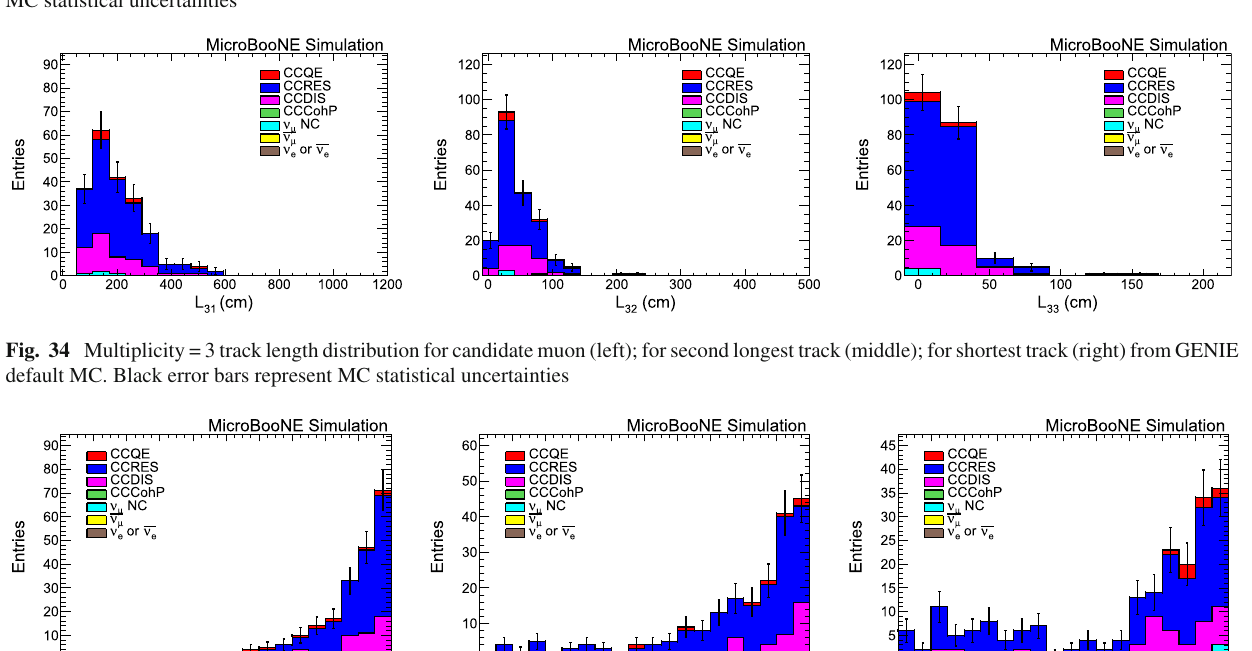
Fig. 33 Multiplicity = 2 φ 2 − φ 1 distribution (left); cosine of opening angle distribution (right) from GENIE default MC. Black error bars represent MC statistical uncertainties